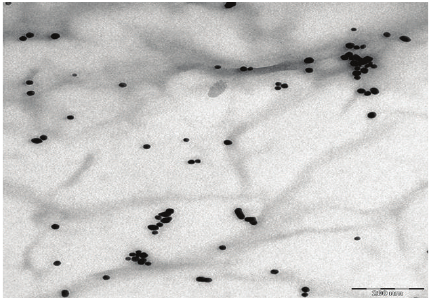
Figure 5: TEM image of chitosan capped AuNPs.